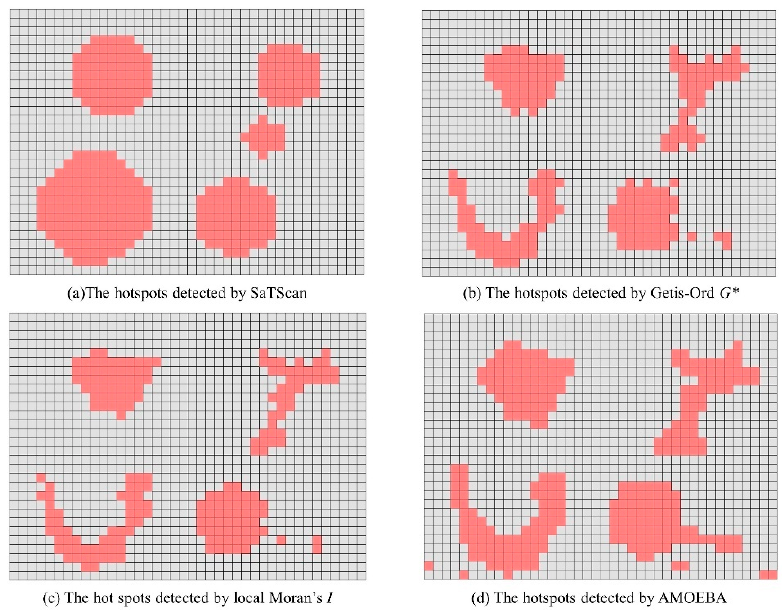
Figure 4. The hotspot detection result of synthetic data.